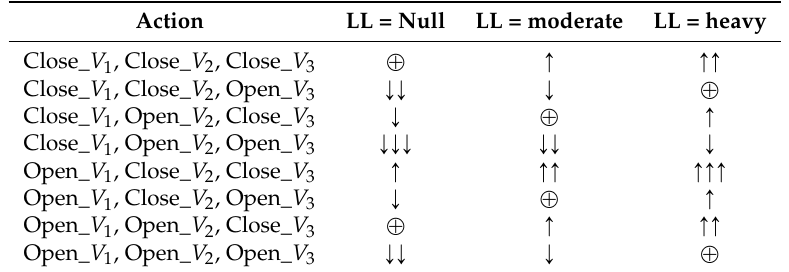
Table 1. Effects of the policy on the dam level ( L ) depending on the rain condition ( LL ).